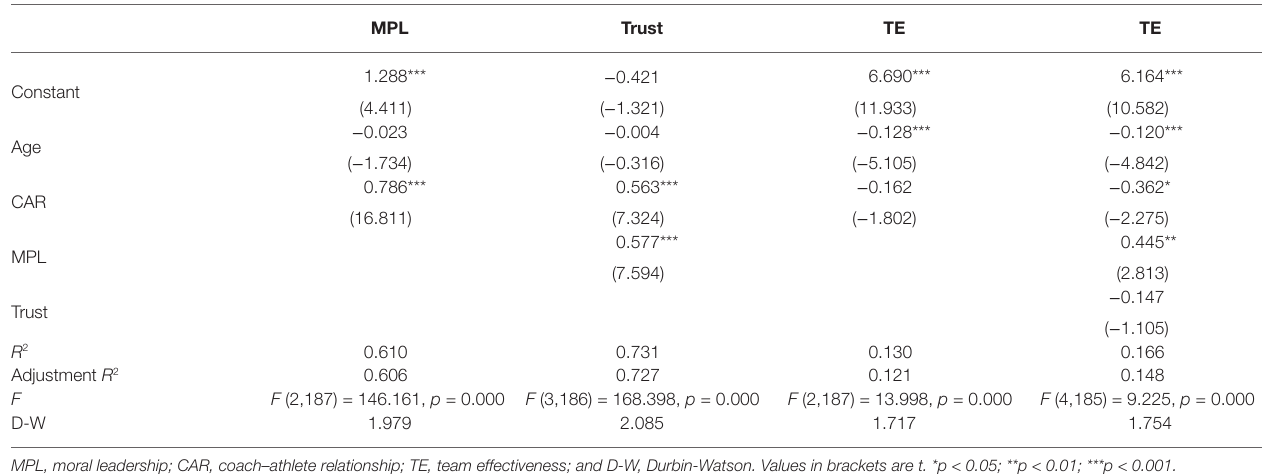
TABLE 3 | Mediation effect test.